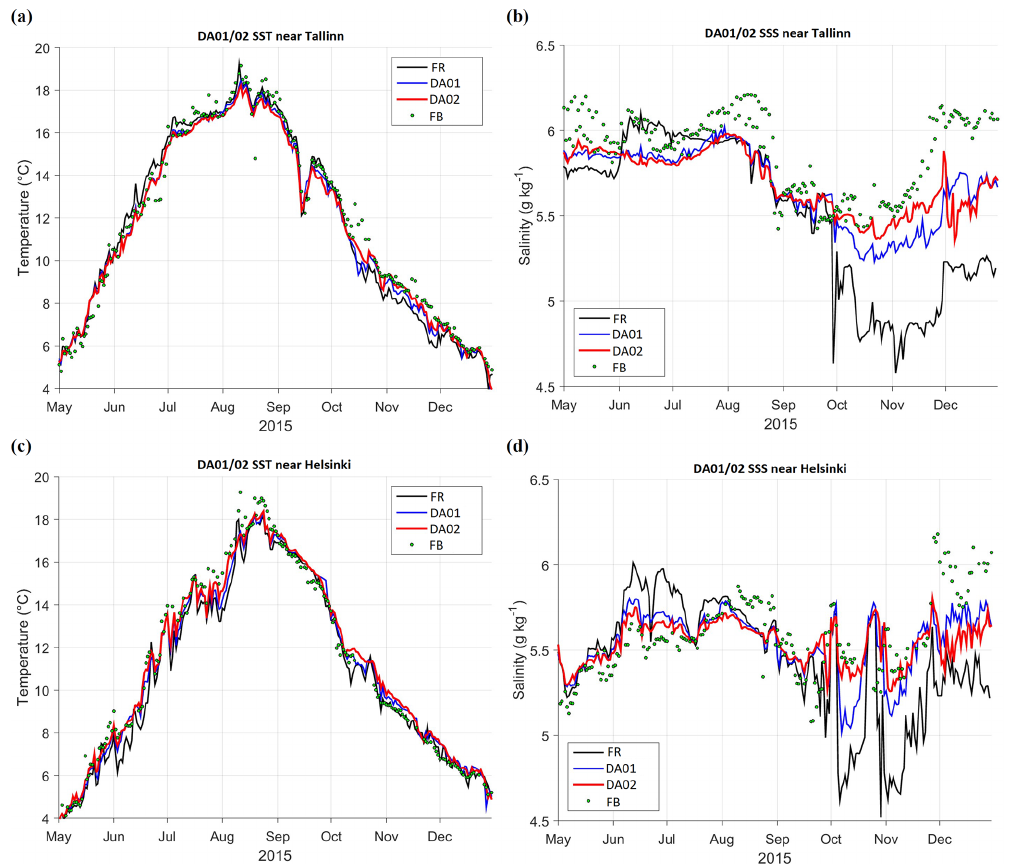
Figure 7. Time series of SST (a, c) and SSS (b, d) near Tallinn ( a, b, 59.4833 ◦ N, 24.7667 ◦ E) and Helsinki ( c, d, 59.9500 ◦ N, 24.8833 ◦ E), locations shown in Fig. 2a. FerryBox data (FB) are shown by dots, black lines represent control run (FR) without DA, red lines correspond to DA with relaxation time 5d (weight of observations 0.2, DA02), blue lines for 10d (weight 0.1,